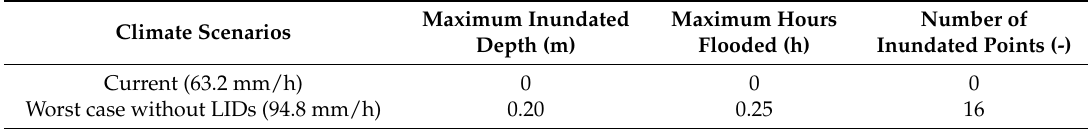
Table 3. Increase of flood risk for future climate